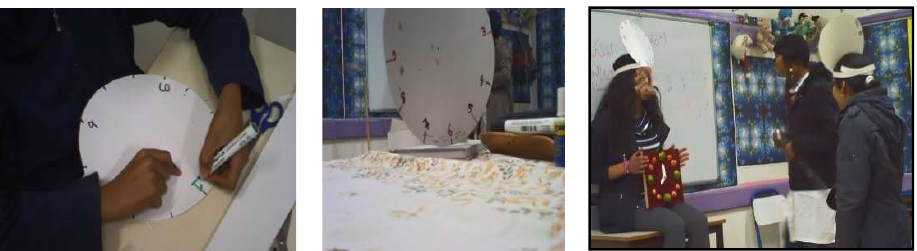
Fig. 8. Apprentissage de mesure du temps par la médiation théâtrale. Fig. 7. Apprentissage de la géométrie et de l’unité de centimétre de l’échantllion témoin (ET)